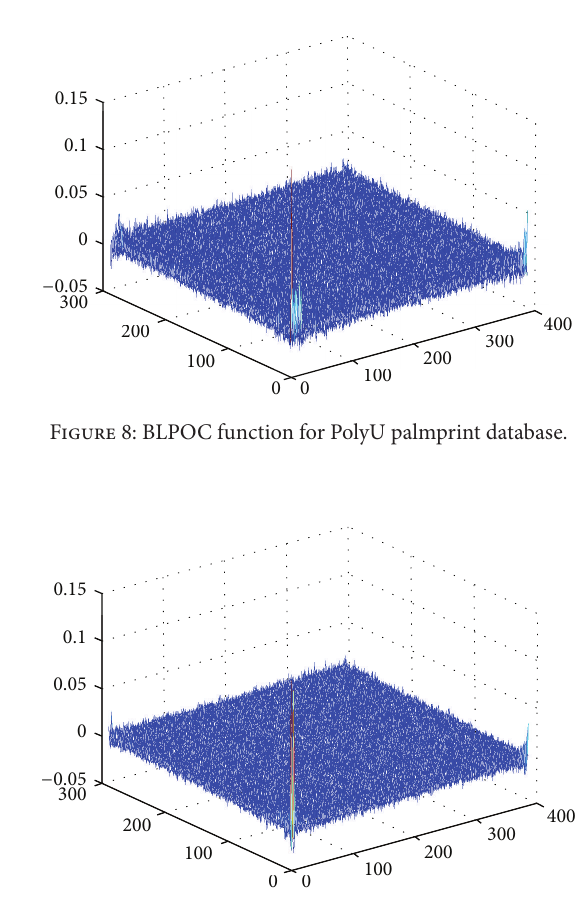
Figure 9: BLPOC function for COEP palmprint database.